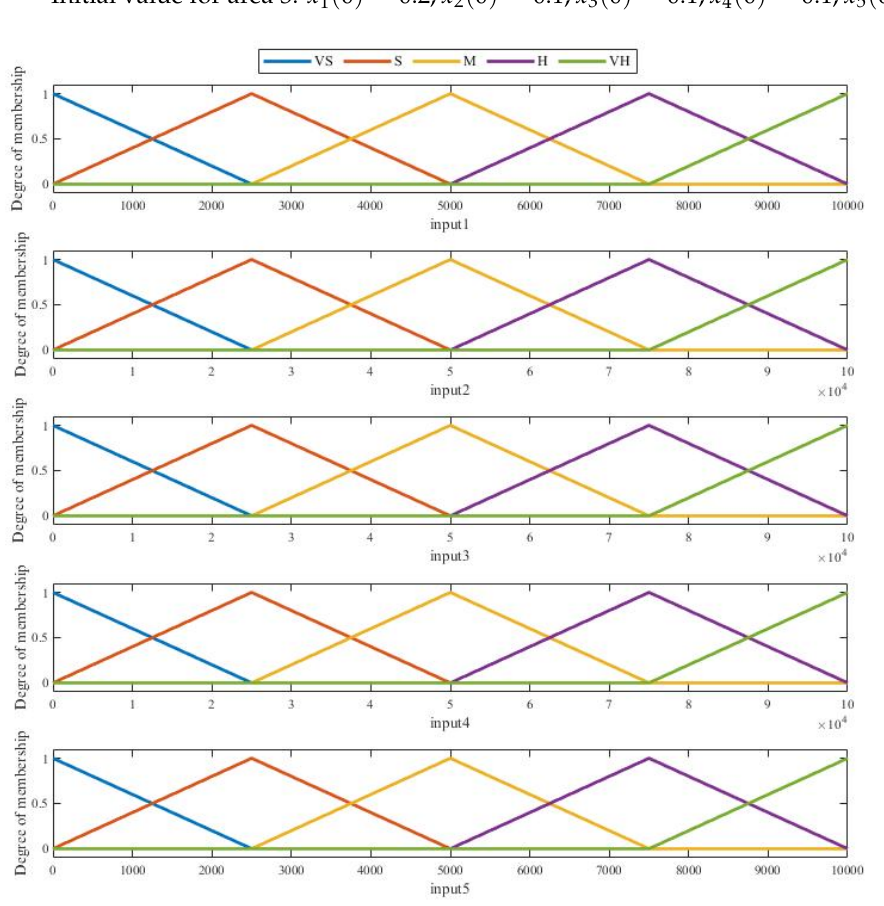
Figure 4. Input membership function Scenarios 1, 2, and